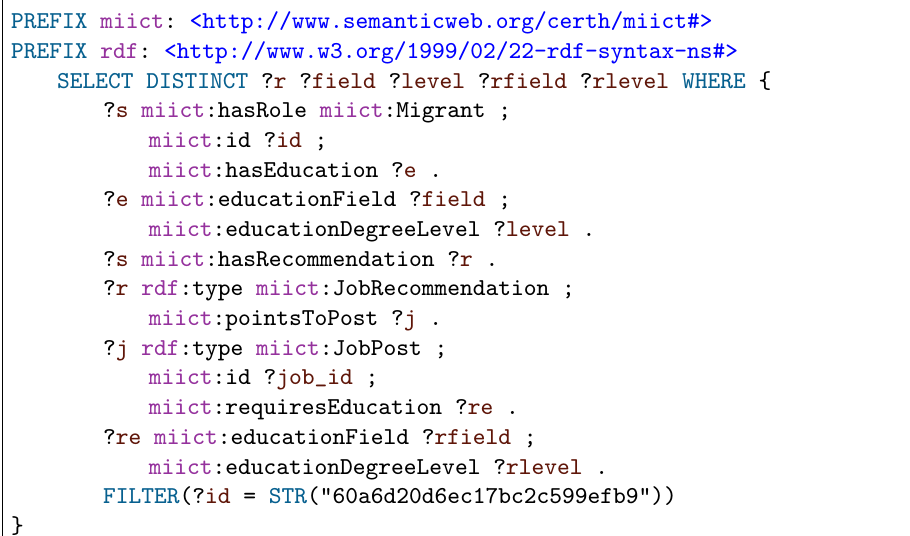
Figure 9. CQ_02: Which job posts match the migrant’s language?